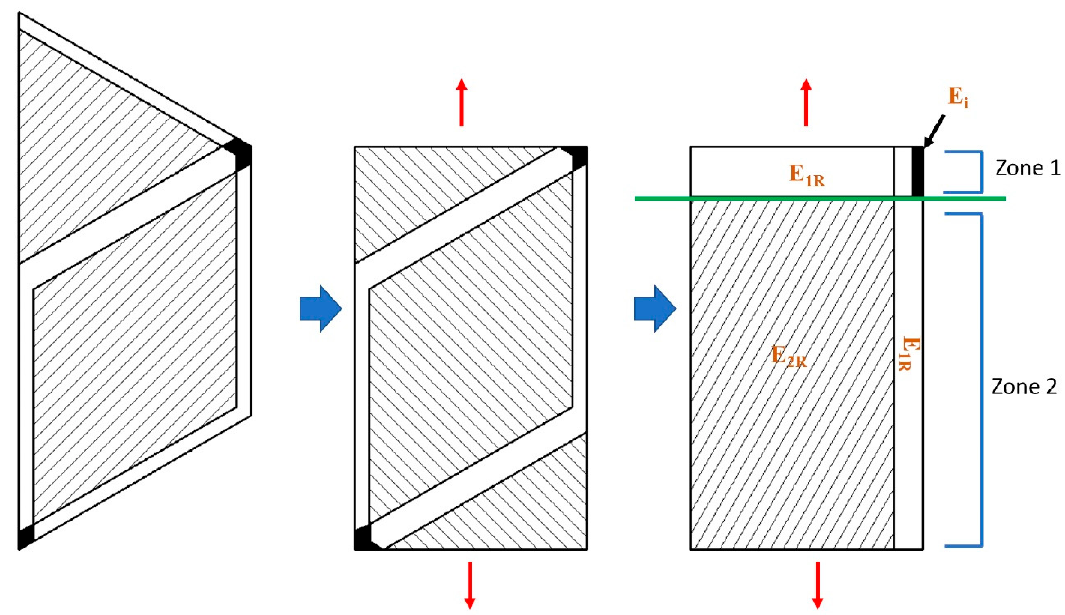
Figure 4. Volume simplification of hexagonal reinforcement.